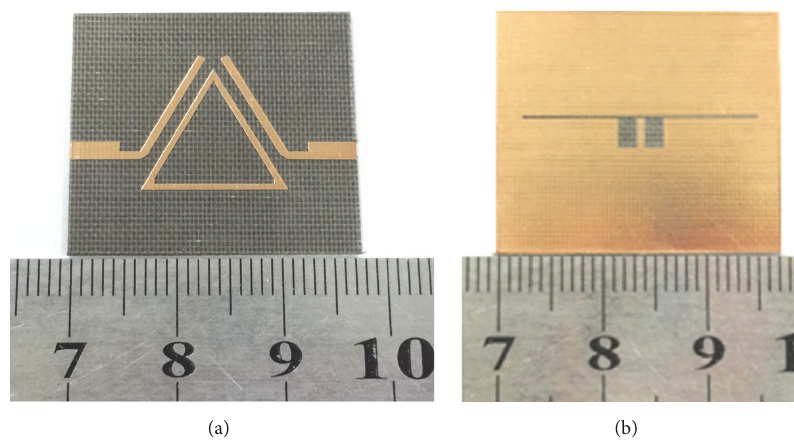
Figure 9: Photograph of the fabricated filter. (a) Top view and (b) bottom view.